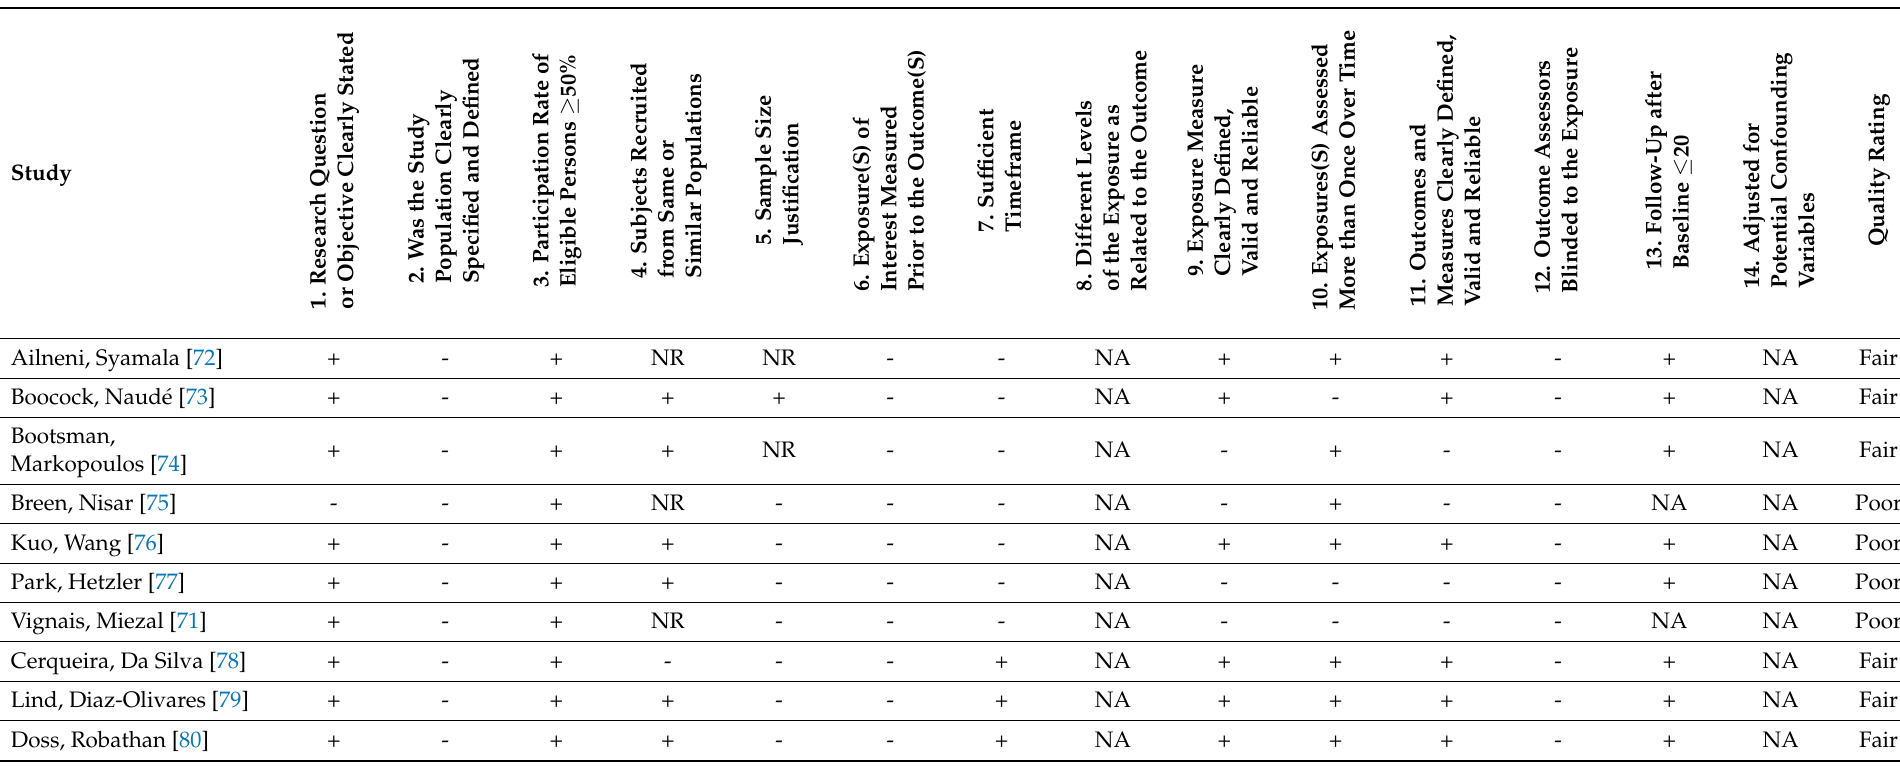
Table 8. Risk-of-bias evaluation for cross-sectional studies ( n = 7) using the National Institutes of Health risk-of-bias tool for observational cohort and cross-sectional studies.